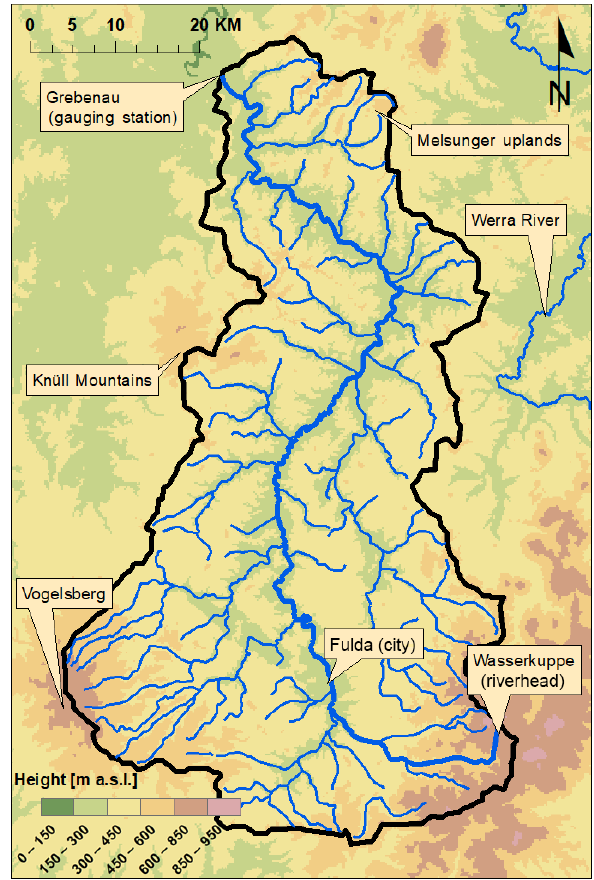
Figure 1. Relief map of the partial catchment of the Fulda River (black border) with side streams, ridges and parts of the Werra River.